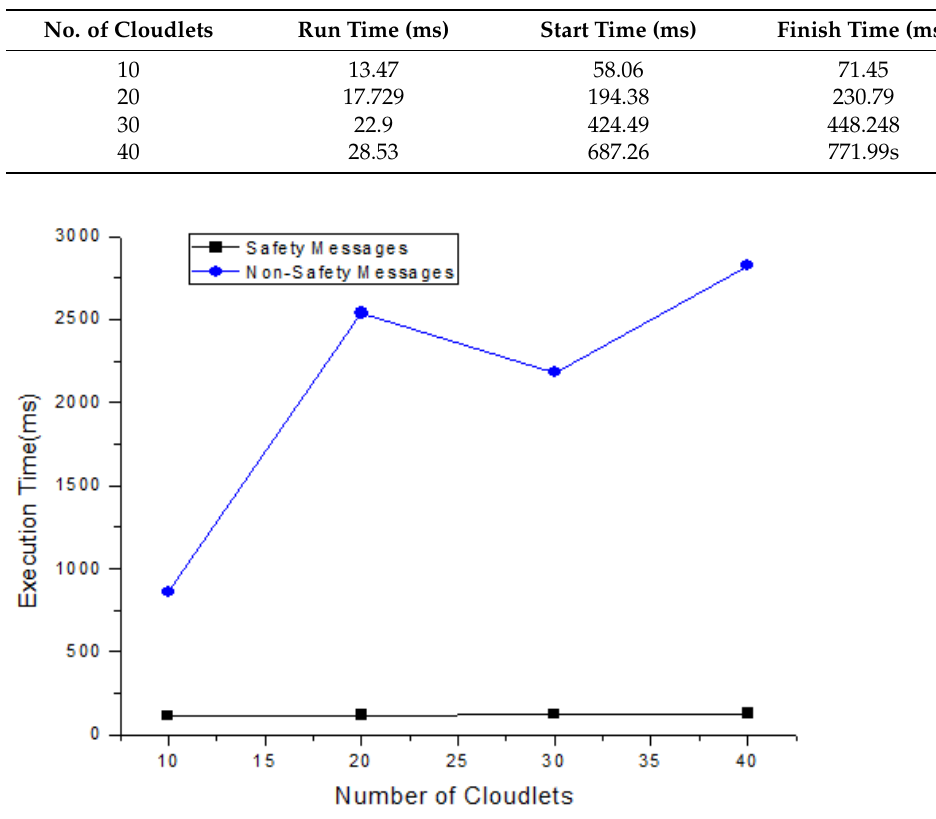
Figure 5. Life Cycle of non-safety messages. Table 8. Total calculated execution time for non safety messages.